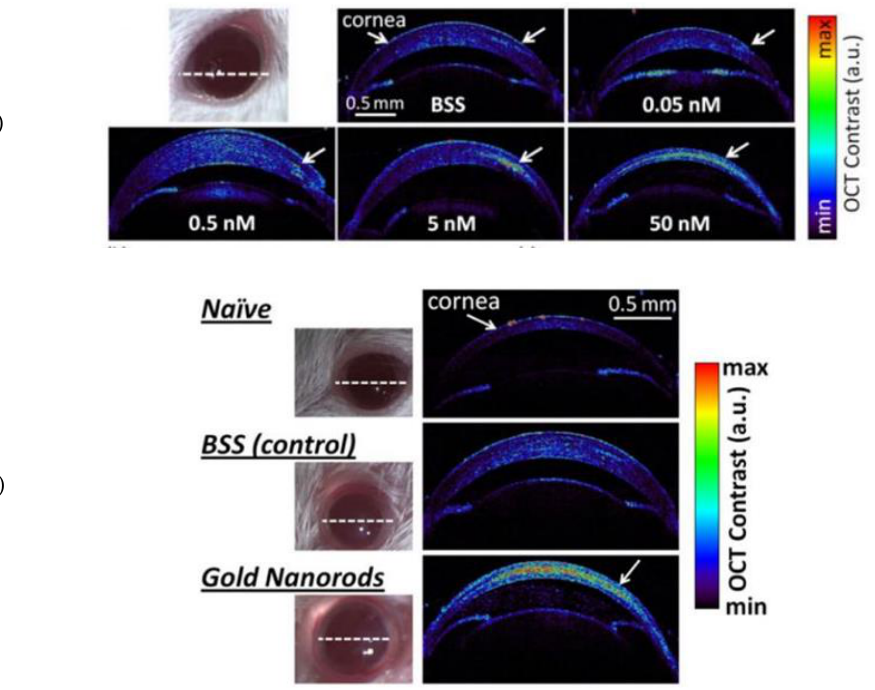
Figure 5. ( a ) Mice corneas injected with 10 µ L GNR-780 at 50 nM (bottom) compared to control mice corneas injected with 10 µ L of BSS (middle) and mice corneas not injected with anything (upper). OCT cross sectional images showed the high contrast by GNR-780 in the cornea; ( b ) mice corneas (N = 4) injected with 5 µ L of GNRs at concentrations from 50 nM to 0.05 nM and control mice injected with BSS. The concentration of 0.05 nM had a contrast similar to control mice, whereas the concentration of ≥ 0.5 nM created a distinct detectable signal [90]. Copyright © 2014 Royal Australian and New Zealand College of Ophthalmologists. ClinExperiment Ophthalmol. Author manuscript; available in PMC 27 Jul 2016. Published in final edited form as: Clin Experiment Ophthalmol. May–Jun